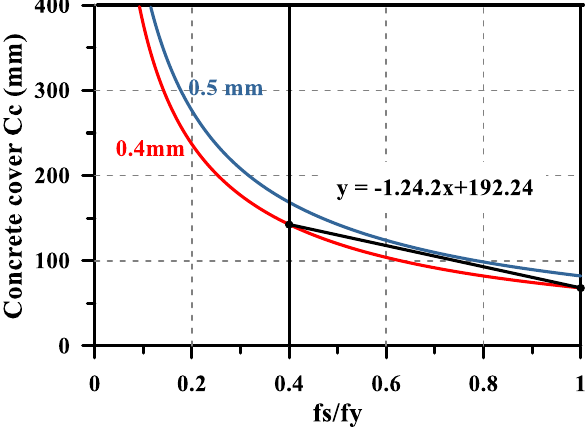
Fig. 21 Simplified equation for the maximum value of d c .